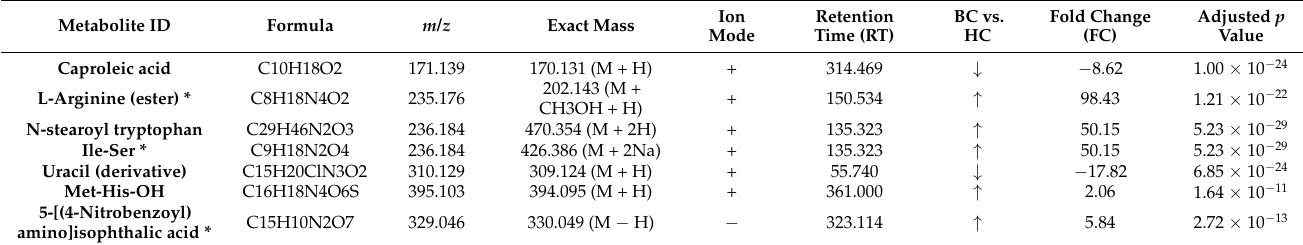
Table 3. Metabolites selected with putative identities.